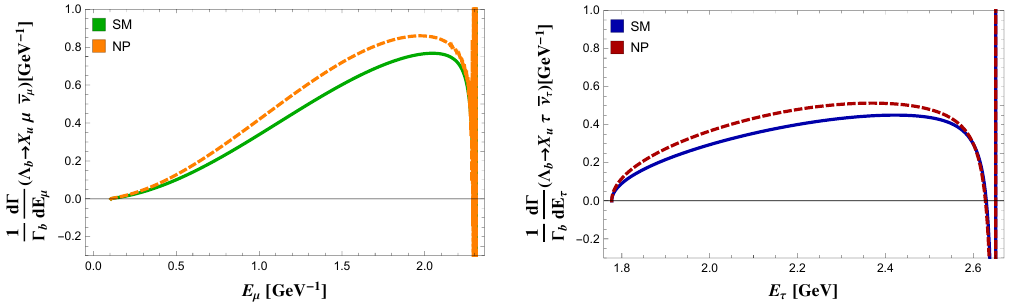
Figure 9 . Charged lepton energy spectrum for (cid:3) b ! X u ‘ (cid:22) (cid:23) ‘ , with ‘ = (cid:22) (left) and ‘ = (cid:28) (right). The solid line corresponds to SM, the dashed line to NP at the benchmark point.